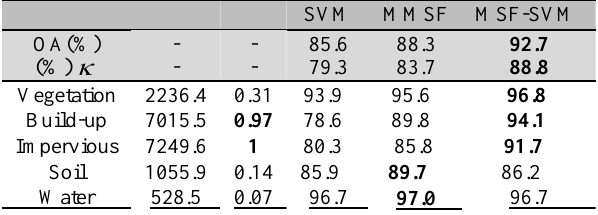
Table 2. The SVM assessment parameters and the classification